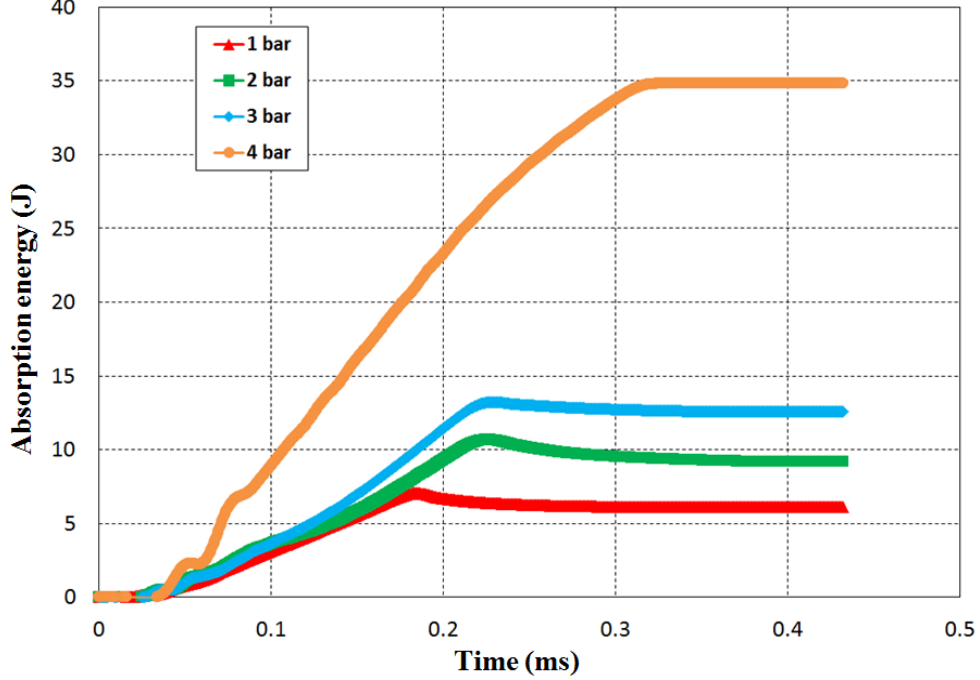
Figure 11. Absorbed energy for an aging time t = 216 h.